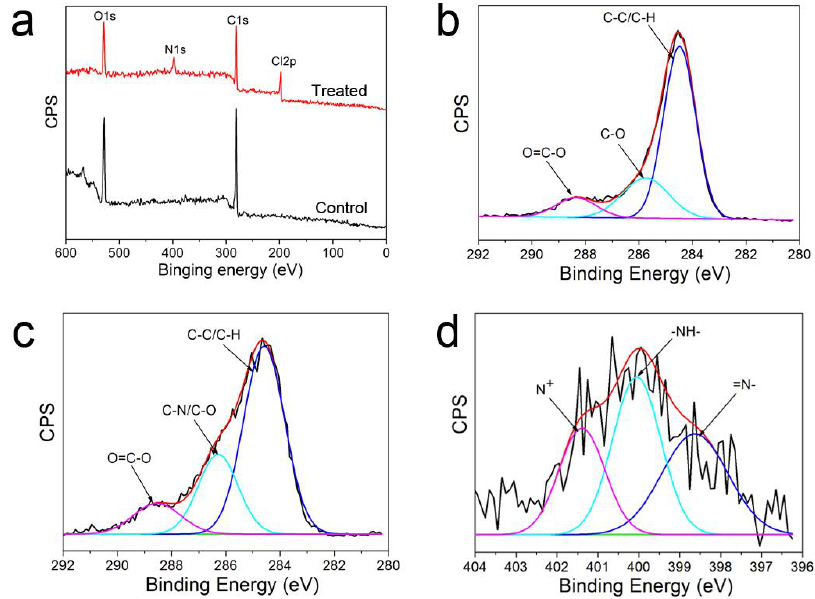
Figure 5. ( a ) XPS wide-scan spectra of PET yarns. High-resolution C1s spectra of ( b ) control and ( c ) optimal PET yarns. ( d ) High-resolution N1s spectra of optimal sample.